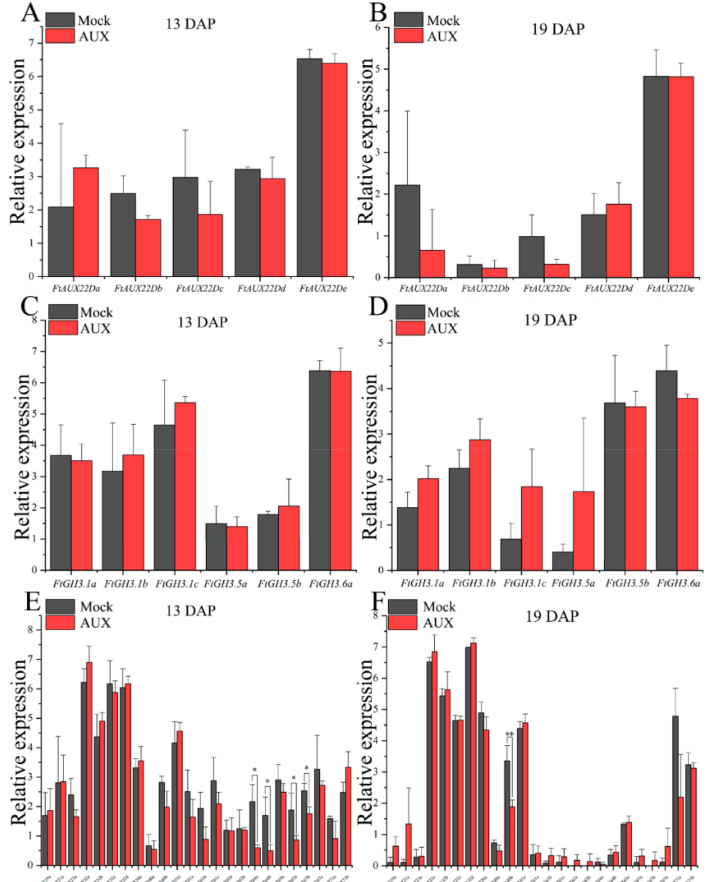
Figure 6. Expression analysis of FtAux/IAAs , FtGH3s , and FtSAURs genes in STB fruits at 13 and 19 DAP under mock and IAA treatments. ( A ) Expression analysis of FtAux/IAA genes in STB fruits at 13 DAP under mock and IAA treatments. ( B ) Expression analysis of FtAux/IAA genes in STB fruits at 19 DAP under mock and IAA treatments. ( C ) Expression analysis of FtGH3s genes in STB fruits at 13 DAP under mock and IAA treatments. ( D ) Expression analysis of FtGH3s genes in STB fruits at 19 DAP under mock and IAA treatments. ( E ) Expression analysis of FtSAURs genes in STB fruits at 13 DAP under mock and IAA treatments. ( F ) Expression analysis of FtSAURs genes in STB fruits at 19 DAP under mock and IAA treatments. * and ** indicate significant differences at 0.05 and 0.01 levels,